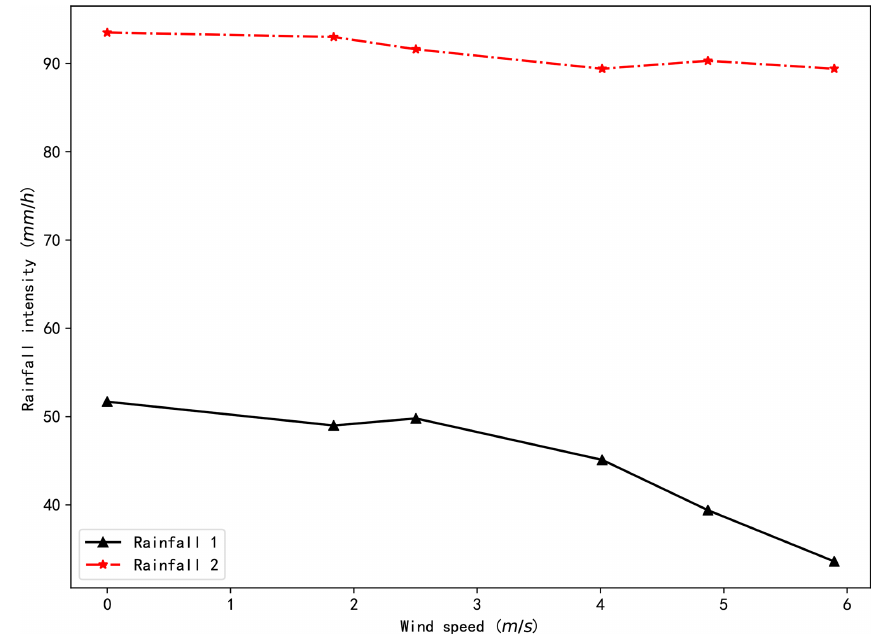
Figure 6. The actual rainfall intensity atop the scale model for different wind speeds under rainfalls 1 and 2.